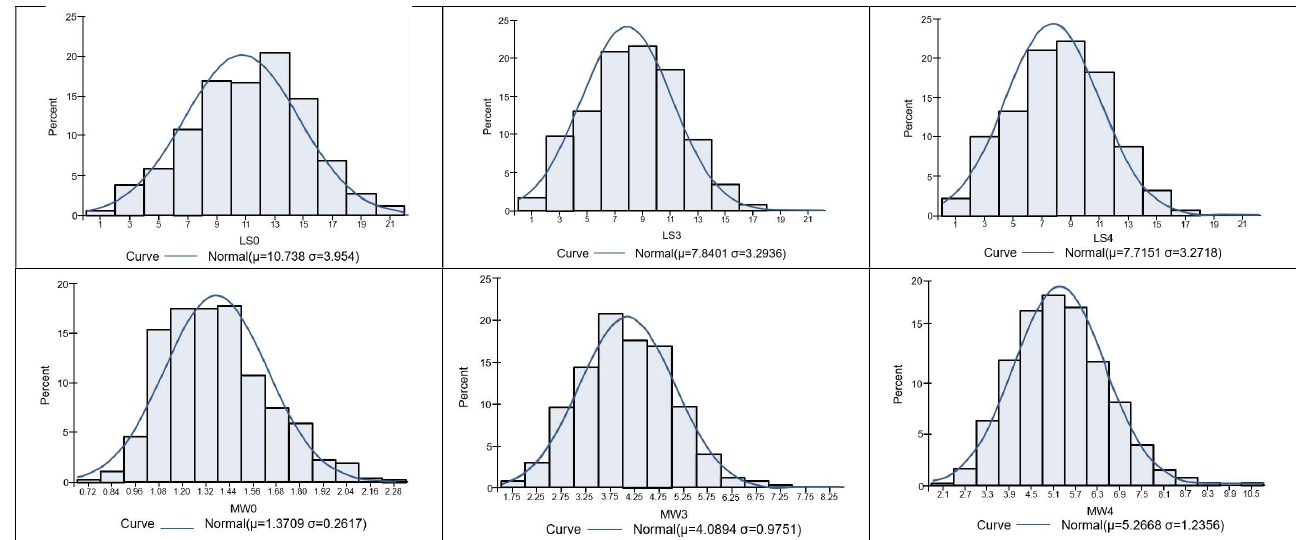
Figure 1. Histograms of the distribution of litter sizes (top: LS0, LS3, and LS4) and piglet weights (bottom: MW0, MW3, and MW4) from birth to 3 weeks or 4 weeks. Table 2. Estimates of heritability (h 2 , diagonals), genetic correlations (r g , upper diagonals), and phenotypic correlations (r p , lower diagonals) of littering performance before weaning with SE using animal models without maternal genetic effects in a three-trait animal model. Litter size at